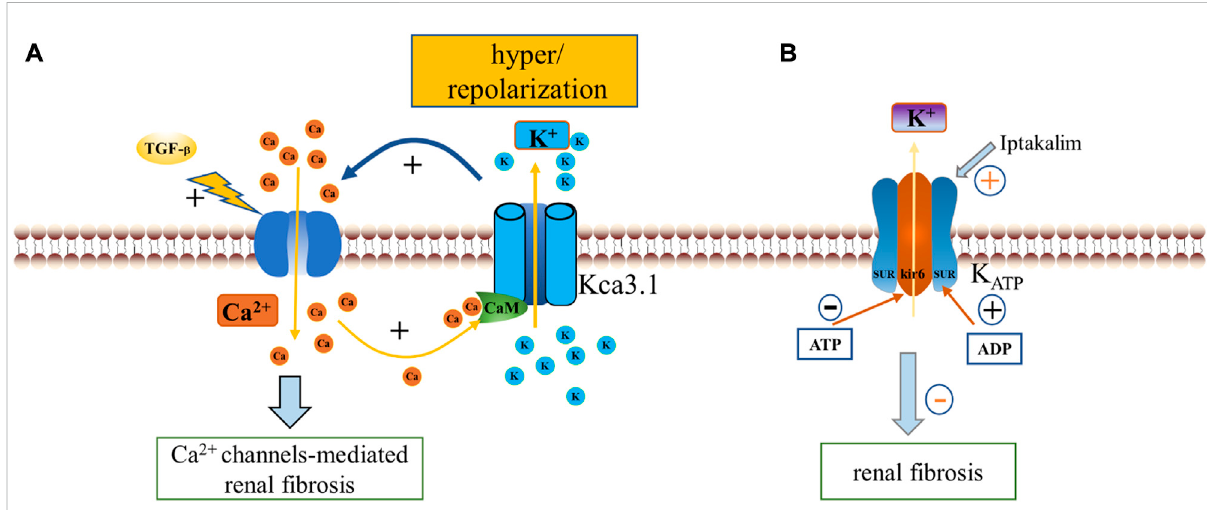
FIGURE 4 Diagram illustrating KCa3.1 channels activity regulating Ca 2+ in fl ux-dependent fi brosis pathway and regulation of K ATP channels opening. (A) . KCa3.1 channels form a positive feedback loop with Ca 2+ channels. TGF - β exposure promotes Ca 2+ inward fl ow, and Ca 2+ binding to the KCa3.1 channel CAM allosterically opens the channel, creating a membrane hyperpolarization or repolarization that further promotes Ca 2+ inward fl ow, thereby triggering Ca 2+ channels-mediated renal fi brosis. (B) . ATP binds to Kir6 subunits to inhibit the channel, while K response to ADP dissociation at the SUR subunit. The iptakalim (a novel KATP channel opener) can open K ATP channels to inhibit renal fi brosis. CAM, calmodulin; KCa3.1, Ca 2+ -activated K + channel 3.1; K ATP , ATP-sensitive K +